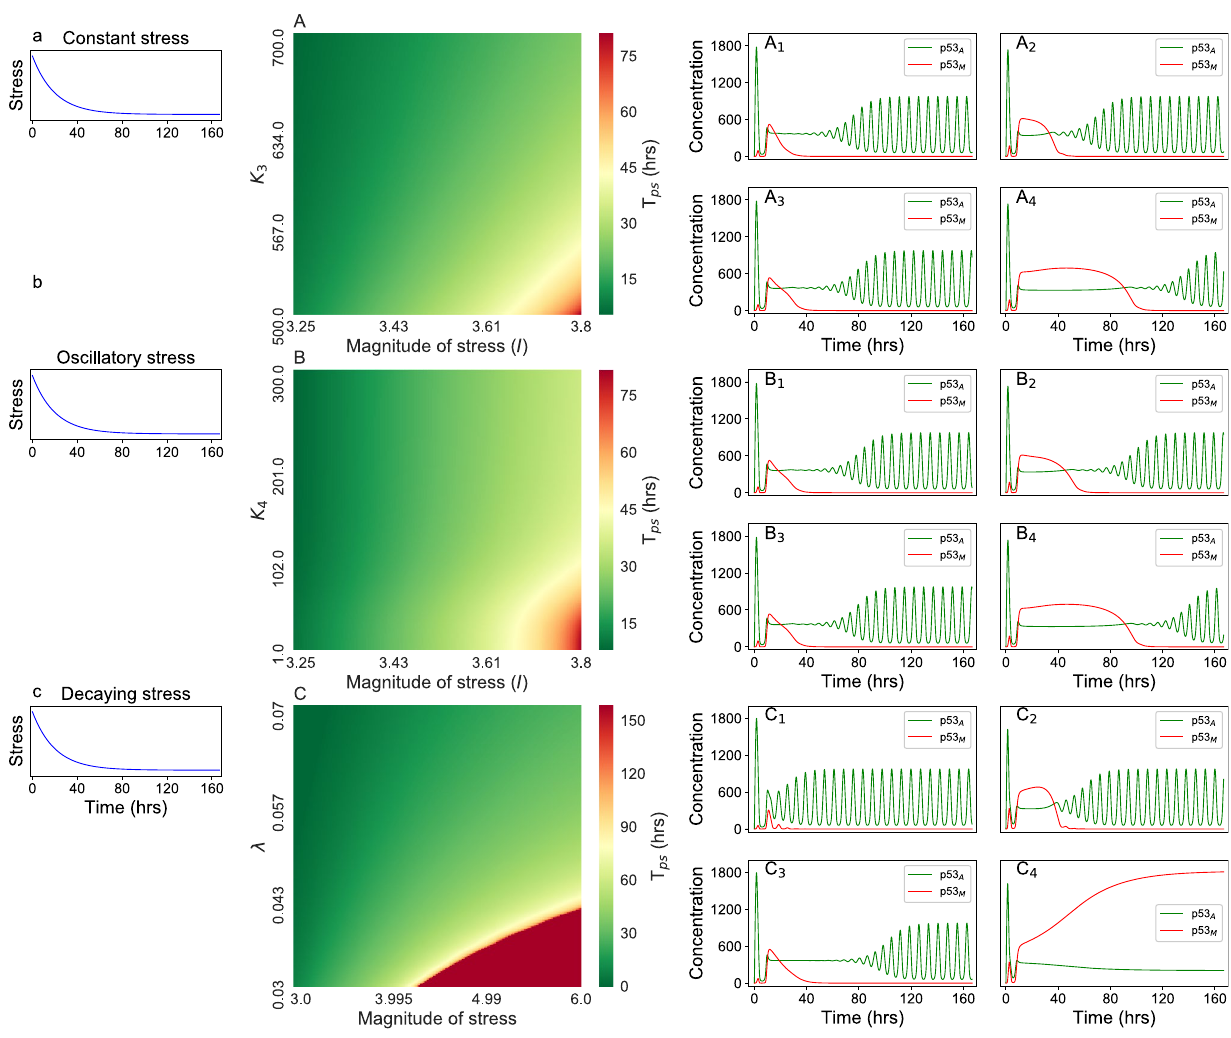
Figure 7. The left column show decaying stress. Second column, ( A – C ), show two parameter cancer recovery behavior for the parameter set ( magnitude of stress , K 3 ), ( magnitude of stress , K 4 ), and ( magnitude of stress , (cid:31) ) respectively driven with same decaying stress. A 1 , A 2 , A 3 , and A 4 correspond to the time course for the parameter set (3.25,700.0), (3.8, 700.0), (3.25, 500.0), and (3.8, 500.0) respectively on the heat map A. B 1 , B 2 , B 3 , and B 4 correspond to the time course for the parameter set (3.25,300.0), (3.8, 300.0), (3.25, 1.0), and (3.8, 1.0) respectively on the heat map B ( K 3 = 500.0 ). C 1 , C 2 , C 3 , and C 4 correspond to the time course for the parameter set (3.0,0.07), (6.0,0.07), (3.0,0.03), and (6.0,0.03) respectively on the heat map C ( K 3 = 1000.0 , K 4 = 10.0 ). On the heat map green color shoes lowest recovery time, while red shows highest recovery time or no recovery (in case of crosses a certain threshold 66 for both p53 A and p53 M ; this is a state of amplitude death leading to a stable fixed- point attractor. This corresponds to apoptosis since the system cannot revert to oscillatory dynamics: this is an irreversible transition 25 . For large stress, the production of mutant p53 M becomes rapid and uncontrolled. The concentration level of p53 M exceeds a critical apoptotic threshold, and this can be seen as stress-induced premature senescence. This suppresses apoptosis and triggers cancer progression 77,78 . For constant or a periodic stress signal, we were able to find a condition where p53 A and p53 M coincide. We term this a critical point of the dynamical system, and this can be considered as leading to a new cancer state: mutant p53 M is uncontrollable ( p 53 M (cid:31) p 53 A ). Furthermore, there is no possibility of DNA repair, and the process is irreversible. However, there is a small range of stress where the concentration of mutant p53 increases slowly, compared to the monotonic increase in the cancer regime. This we term as pre-malignant. For constant or periodic stress, there is a single critical point and hence the system, having transitioned to the cancer state cannot revert to the normal state. For exponentially decaying stress, only three states can be observed: active, pre-malignant or cancer. There are two critical points, in this case, indicating the possibility of reversing from the pre-malignant to the active state. The width of the transition region depends on the stress-inducing parameters with respect to oncogene,